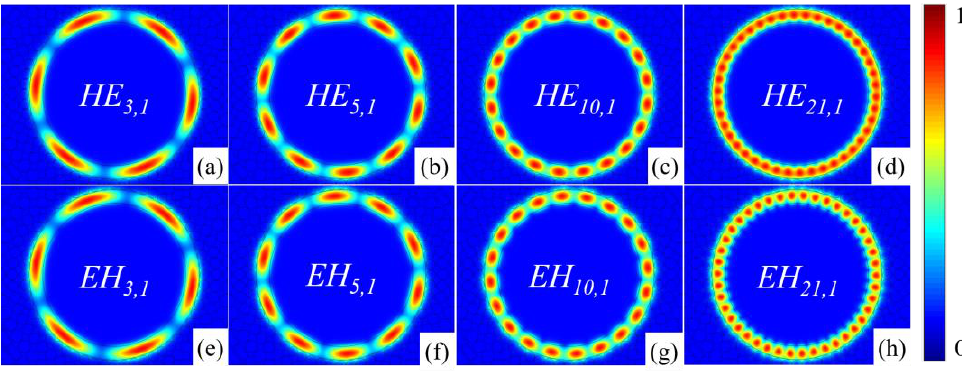
Figure 3. Mode field distribution diagram: ( a ) HE 3,1 , ( b ) HE 5,1 , ( c ) HE 10,1 , ( d ) HE 21,1 , ( e ) EH 3,1 , ( f ) EH 5,1 , ( g ) EH 10,1 , ( h ) EH 21,1.